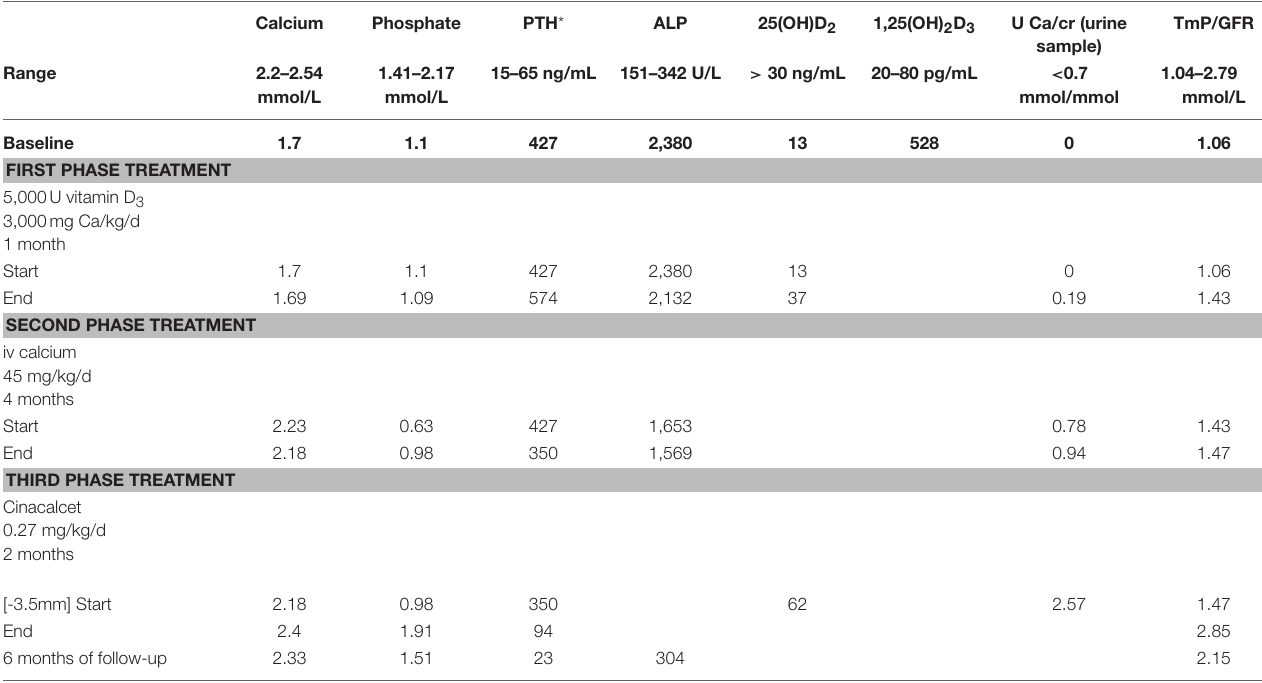
TABLE 1 | Patient’s serum biochemistry evolution and treatment